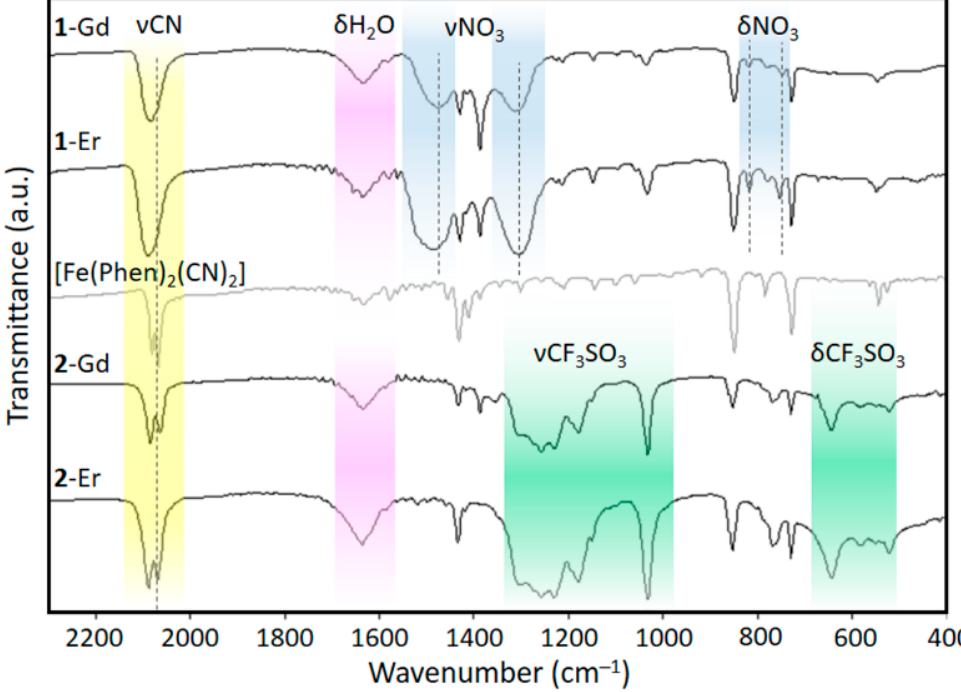
Figure 3. FT-IR spectra of compounds 1 -Ln and 2 -Ln (Ln = Gd, Er) compared with the precursor [Fe(Phen) 2 (CN) 2 ].